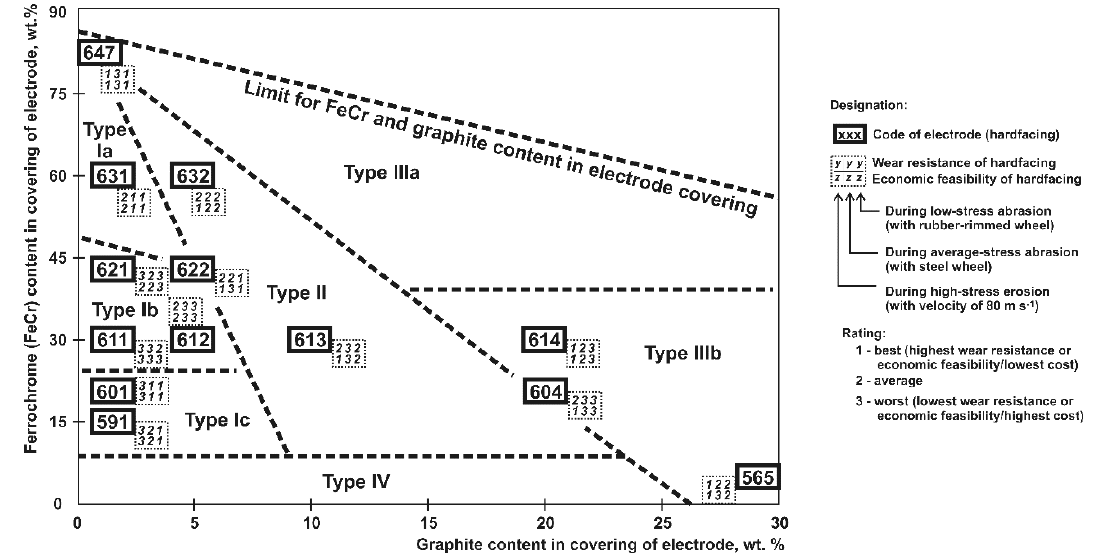
Figure 10. Wear and economic feasibility map for electrodes and resulting Fe–C–Cr manual arc-welded hardfacings.